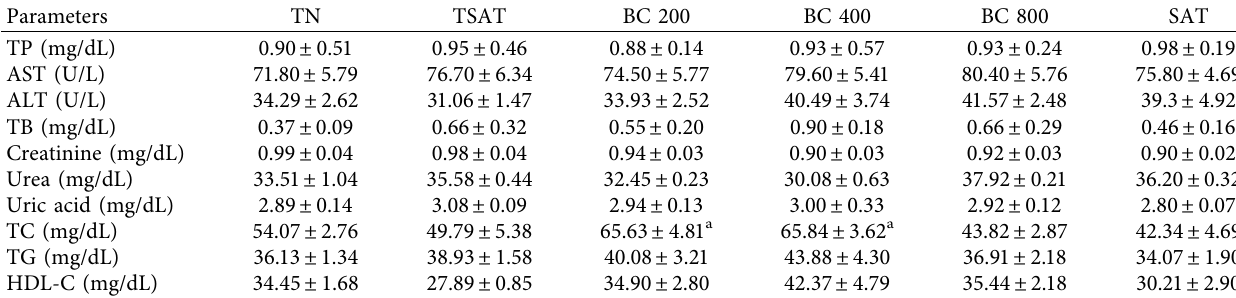
Table 4: Efects of the plant mixture aqueous extract on serum biochemical parameters in females. Parameters